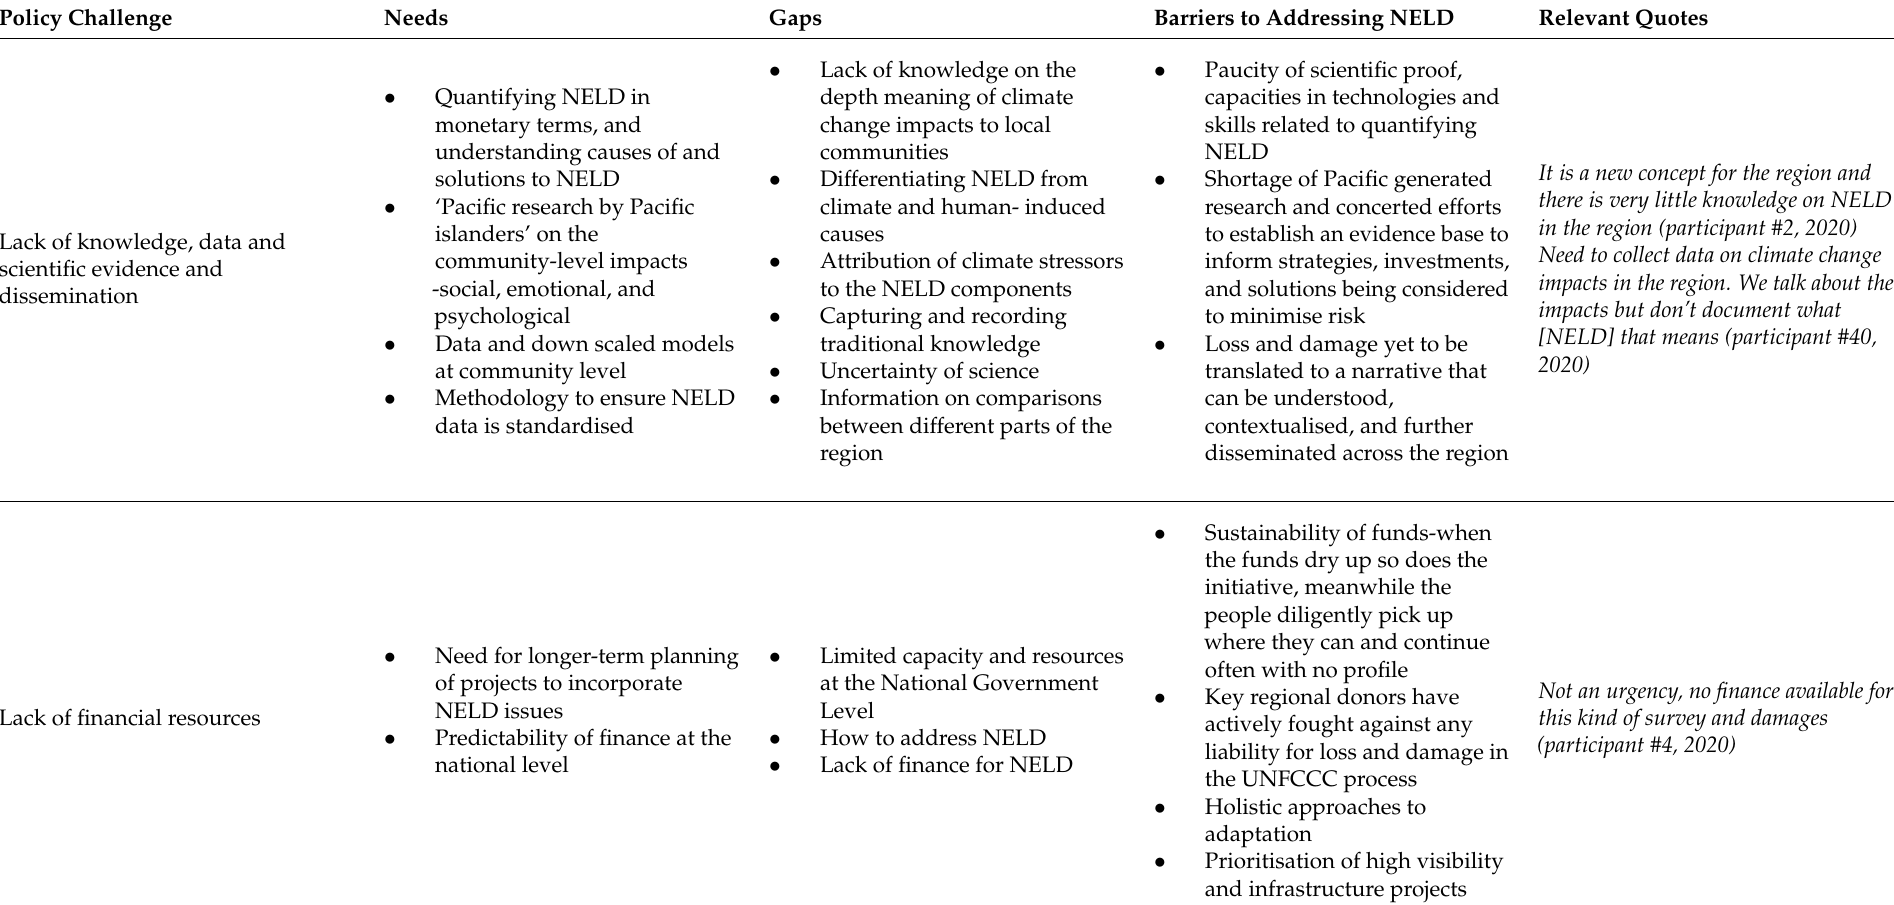
Table 1. Exploring policy needs, gaps and barriers related to Pacific SIDs region’s ability to address